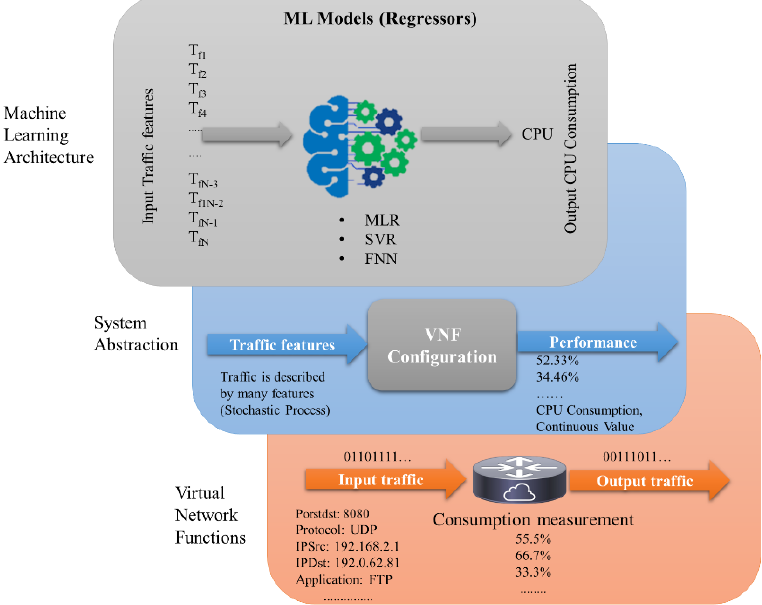
Figure 3. VNF Performance model.